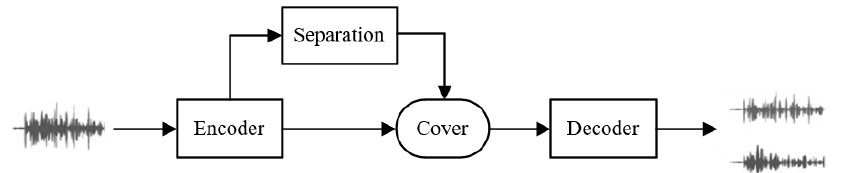
Figure 2. A schematic diagram of Conv-TasNet.